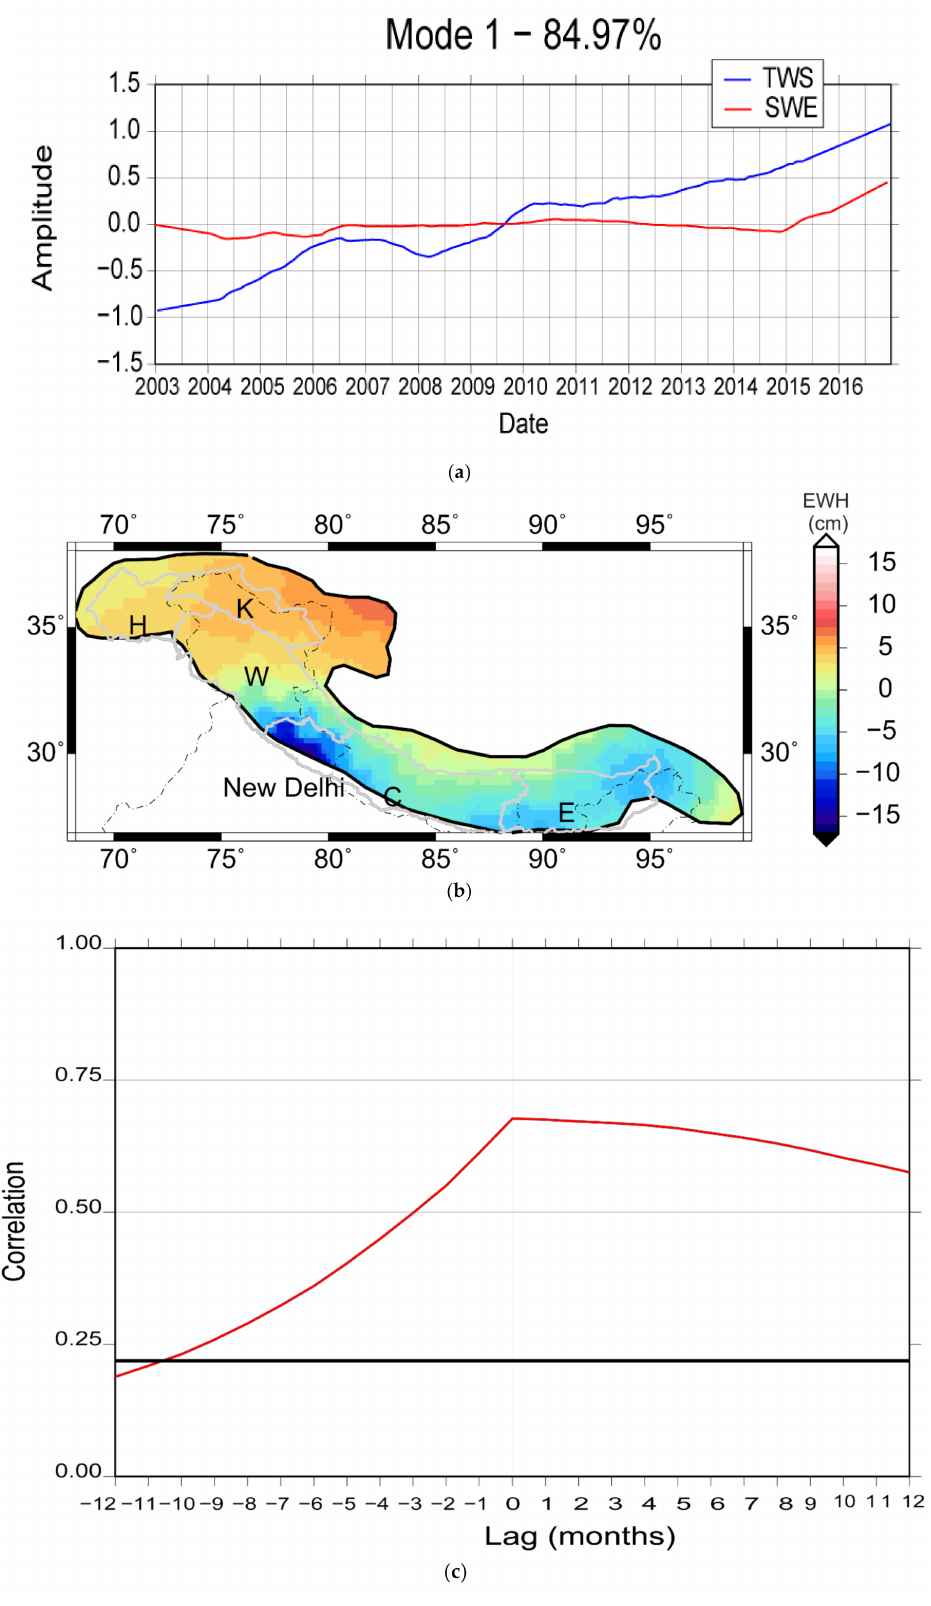
Figure 5. Spatio-temporal variation of the interannual part of GRACE time series. ( a ) Timeseries of Mode 1 and snow cover in water equivalents (SWE). ( b ) Mode1 EOF spatial pattern. ( c ) Cross-correlation of Mode 1 against snowfall and